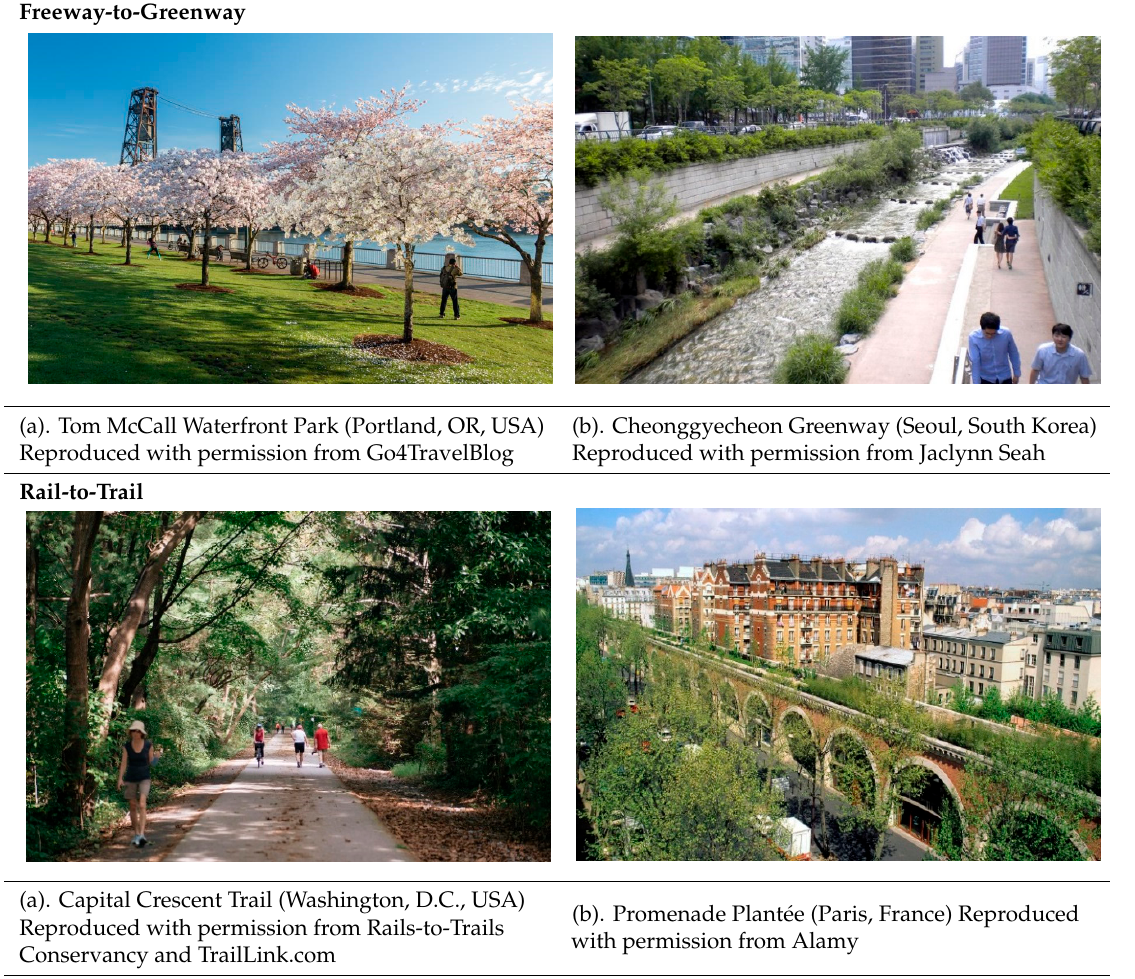
Table 7. Greenway typology: photographic